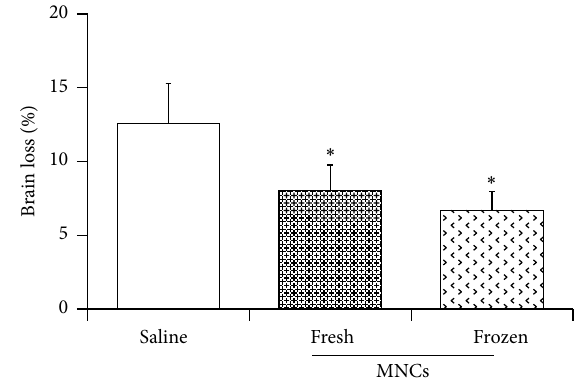
Figure 3: The bar graph exhibiting significantly reduced cerebral atrophy by both fresh MNCs and frozen MNCs at 28 days after stroke. Data are mean ± SD. 𝑛 = 10 in saline group, 𝑛 = 8 in fresh MNCs group, and 𝑛 = 8 in frozen MNCs group. ∗ : 𝑝 < 0.05 compared with saline